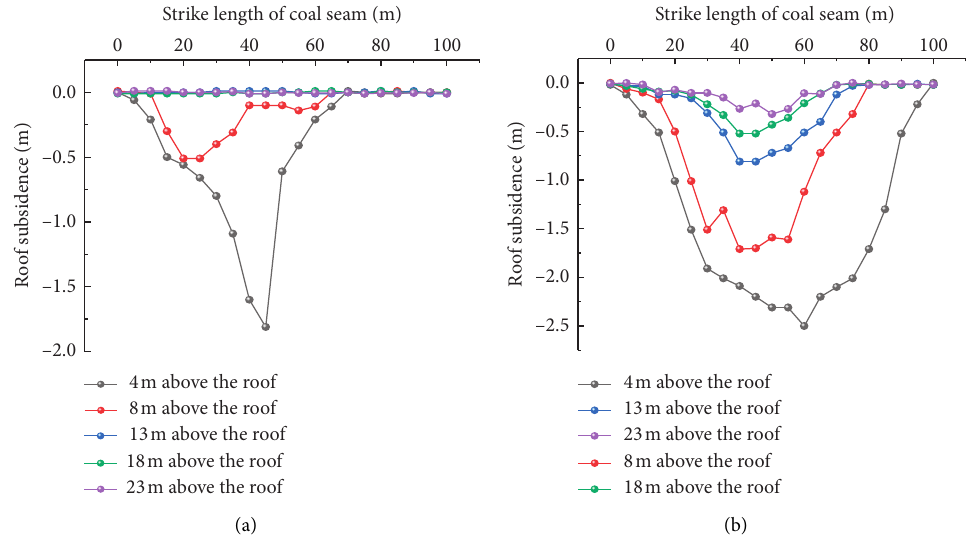
Figure 8: Displacement curve of the roof. Coal seam excavation: (a) 45m; (b)